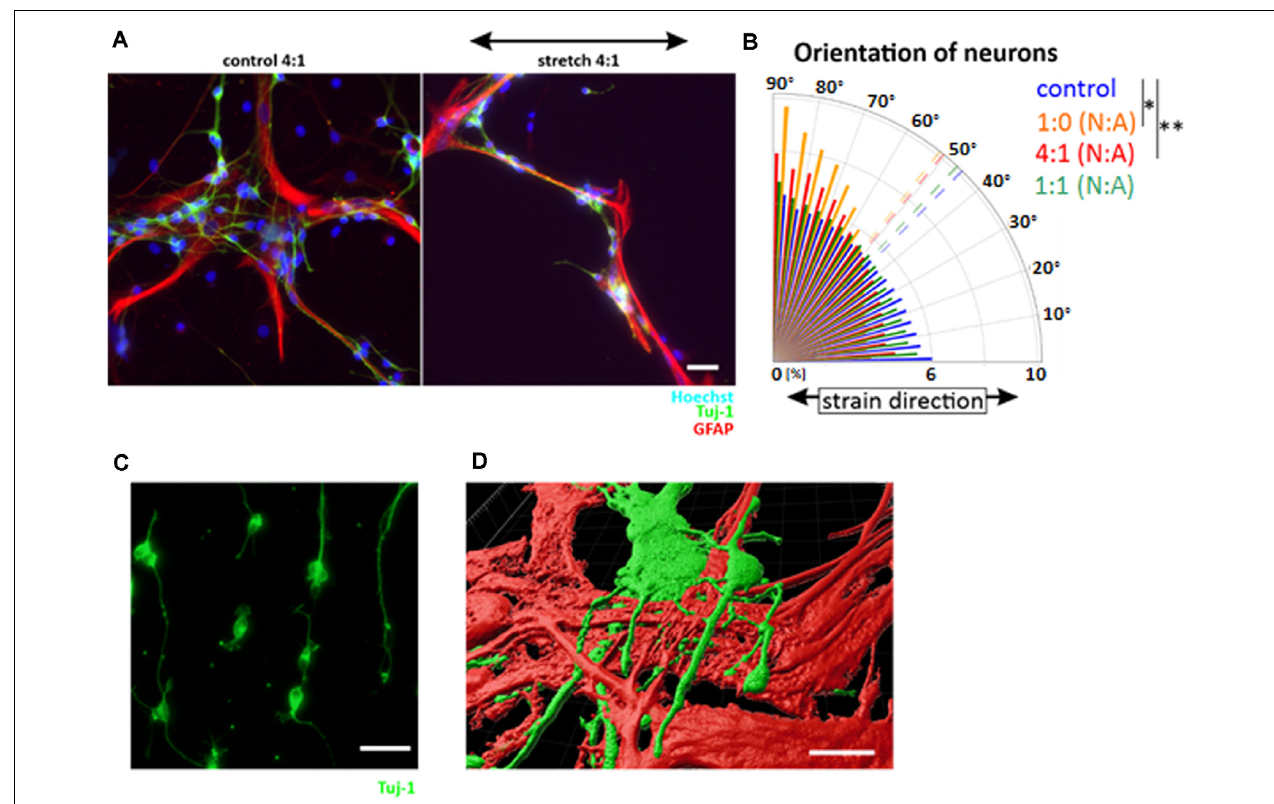
FIGURE 6 | Mechanoprotective effect of postnatal astrocytes. Cocultures of neuronal cells and astrocytes were produced by cultivating cortical neurons and postnatal astrocytes in different ratios and stretched for 24 h (A) . The orientation plot shows different degrees of reorientation depending on the number of astrocytes in the coculture (B) . Statistics was performed comparing the mean orientation: 4:1 neurons (N): astrocytes (A) p -value = 0.002, 1:0 N:A p -value = 0.022, n ≥ 3 independent experiments, from four different passages (mean values indicated as dashed lines). Cortical neurons stretched with the same parameters show a perpendicular orientation to stretch (C) . 3D view of neurons on top of astrocytes (D) . Scale bars = 20 µ m. ∗ define significant differences (see “Material and Methods”